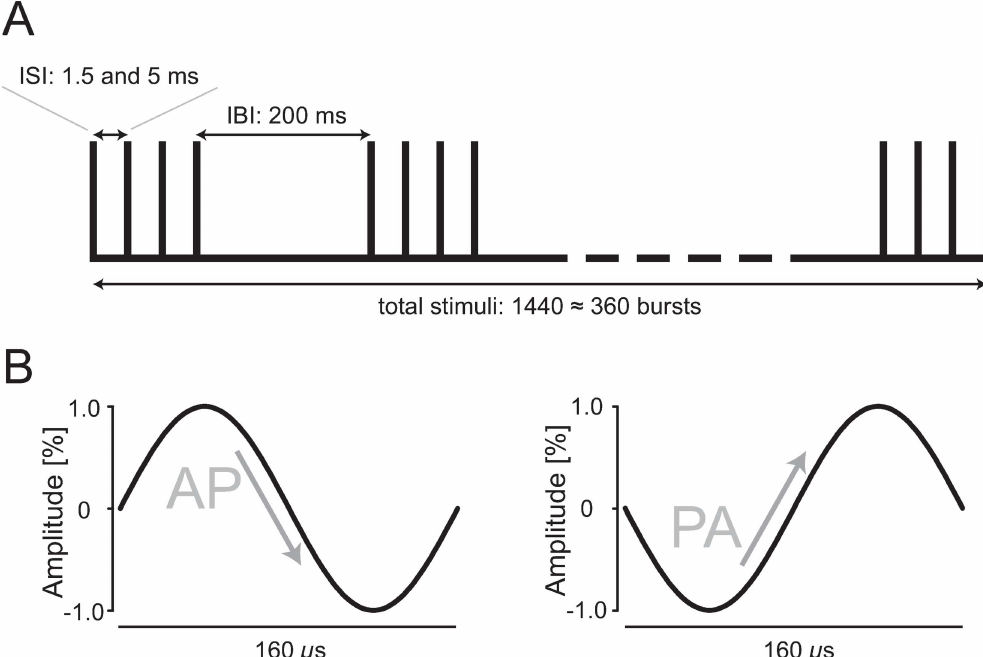
Fig 2. Schematic drawing of qTBS pulse sequence and of current waveforms. (A) The conditioningprotocolof qTBS comprises360 trains of TMS pulses. Each train consists of four biphasicmagneticpulses (i.e. quadri-pulse stimulation;QPS) deliveredat interstimulus intervals of 1.5 ms and 5 ms resultingin a total of 1440 stimuli. Trains were repeated every 200 ms. (B) Each stimulus had a biphasiccurrent waveform with 160 μ s pulse duration. To reverse current directionfrom PA to AP and vice versa, a cable was connectedto the coil changingthe polarity of the inducedcurrent, hereby flippingthe directionof the inducedcurrent in the M1-HAND. We refer to PA stimulation when the initiallyinducedcurrent in M1-HAND had a posterior-to-anterior directionand, conversely, AP stimulation refers to stimulationproducing an anterior-to-posteriorcurrent flow in M1-HAND. For clarity, current direction always refers to the directionof current inducedin M1-HAND by the second componentof the inducedcurrent coveringthe second and third quarter of the biphasiccycle. ISI: interstimulus interval, IBI: interburst